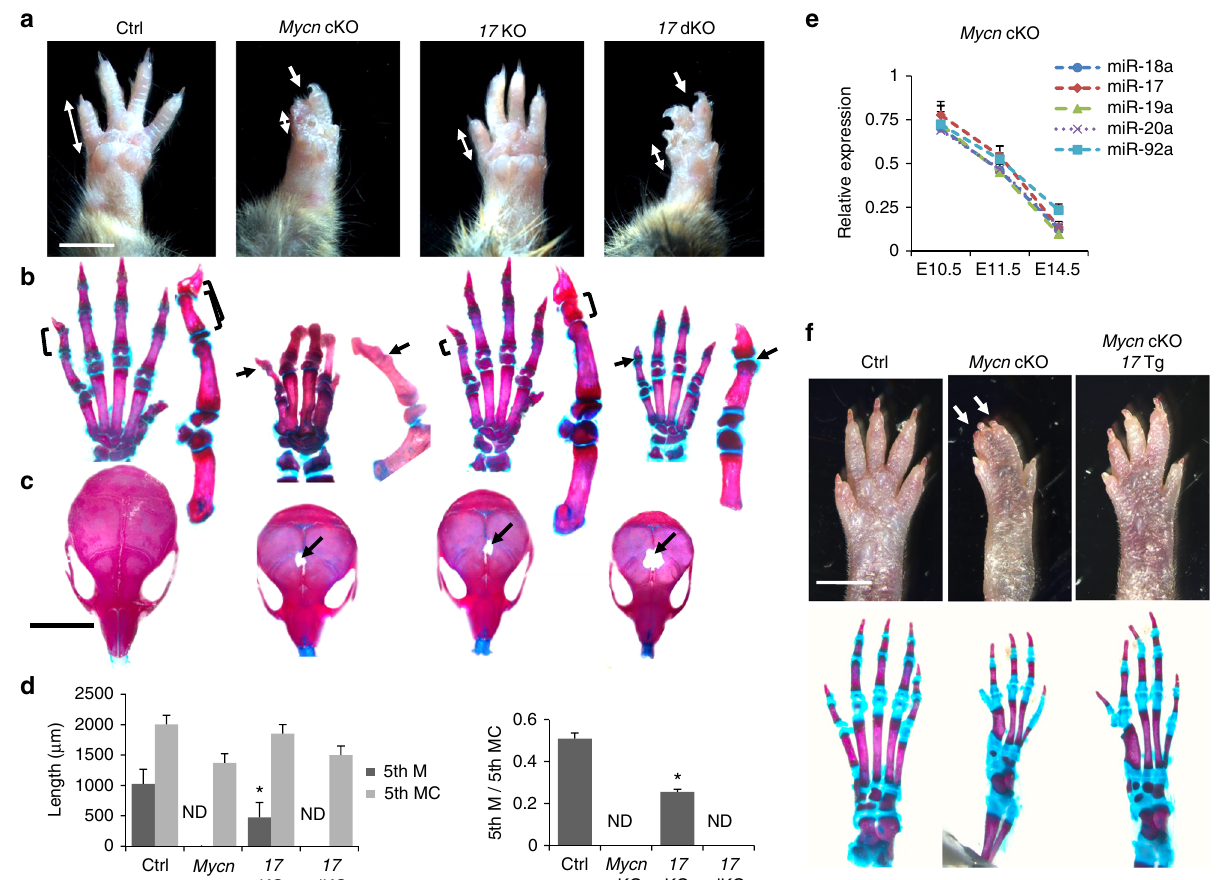
Fig. 1 Generation of mouse models of Feingold syndrome. a Forelimbs of wildtype control (Ctrl), Mycn Knockout ( Prx1-Cre:Mycn fl / fl , Mycn cKO), Mir17-92 knockout ( Prx1-Cre:Mir17-92 fl / fl , 17 KO), and Mir17-92 and Mir106b-25 doubly conditional knockout ( Prx1-Cre:Mir17-92 fl / fl :Mir106b-25 − / − , 17 dKO) mice at postnatal day (P) 16. 17 KO mutants exhibit mild brachydactyly in the fi fth digit (double-headed arrows). Cutaneous syndactyly (arrows) and severe brachydactyly are presented in 17 dKO and Mycn cKO mice. Scale bar, 0.5 cm. b Alizarin red and alcian blue staining of the forelimb and magni fi ed views of the fi fth digit of corresponding mice in a . 17 KO mutants show shortening of the middle phalanx (M) (brackets) of the fi fth digit. 17 dKO and Mycn cKO mutants show severe brachymesophalangy and the absence of the middle phalanx of the fi fth digit (arrows). c Alizarin red and alcian blue staining of the skull of corresponding mice in a . Mycn cKO, 1 7 KO, and 17 dKO mice show microcephaly and a frontal bone ossi fi cation defect (arrows). Scale bar, 1 cm. d Quanti fi cation of the length of the fi fth M and fi fth metacarpal bone (5th MC) and the ratio of 5th M to 5th MC. Values are expressed as mean ± SE ( n = 5 in each group, * p < 0.001 vs. Ctrl). ND, not detected. e Relative expression of fi ve miRNAs encoded in the Mir17-92 gene in limb bud mesenchymal cells isolated from Mycn cKO embryos at embryonic day 14.5. (relative to control littermate samples, n = 5 each group, *<0.001 vs. Ctrl at every time point). f Hindlimbs of wildtype Ctrl, Mycn cKO, and Mycn Knockout overexpressing Mir17-92 ( Prx1-Cre:Mycn fl / fl :Mir17-92 Tg , Mycn cKO: 17 Tg) (upper panels) and alizarin red and alcian blue staining of the hindlimbs of corresponding genotypes (bottom panels). Mir17-92 overexpression partially rescues the skeletal defects of Mycn cKO mutants. Cutaneous syndactyly (white arrows) and shortening of the fi fth digit in Mycn cKO mutants are rescued by overexpression of Mir17-92 whereas fused fourth and fi fth metatarsal bones still remain (bottom panels). Scale bar, 0.5